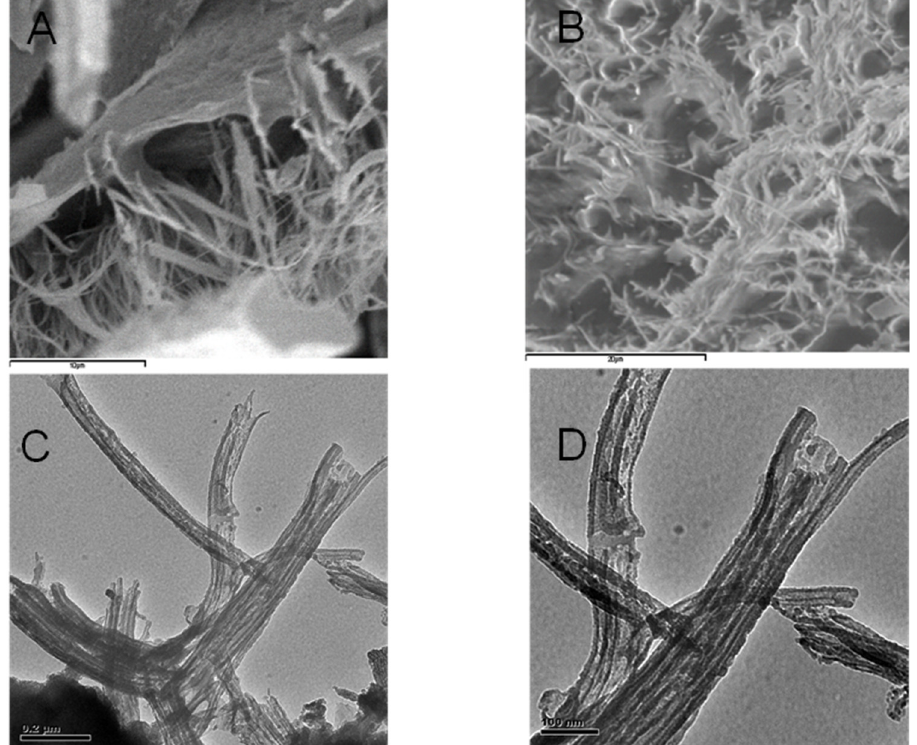
Figure 5. ( A , B ) SEM microtopographies of HA dispersed in alcohol and then adsorbed and dried on mica surface. ( C , D ) TEM microtopographies of HA dispersed in alcohol in forward film.